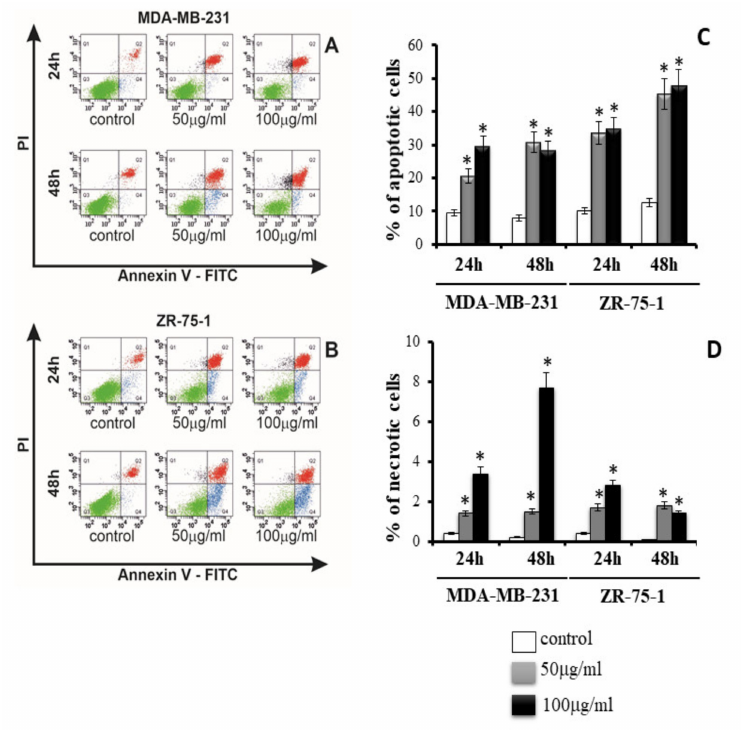
Figure 3. The effect of rGO on apoptosis ( A – C ) and necrosis ( A , B , D ) of MDA-MB-231 and ZR-75-1 cells was evaluated by Annexin V assay. The cells were incubated for 24 h and 48 h in medium with 50 µ g/mL or 100 µ g/mL rGO. The cells were double-stained with FITC-Annexin V and PI. Representative dot plots for Annexin V-FITC/PI staining are shown ( A , B ). The bar graphs present the percentage of apoptotic cells ( C ) and necrotic cells ( D ). Following acquisition of the sample, the cells were gated by the forward scatter FSC and side scatter SSC and analyzed for fluorescence intensity of FITC-Annexin V/PI. The cells were divided into four subpopulations: live